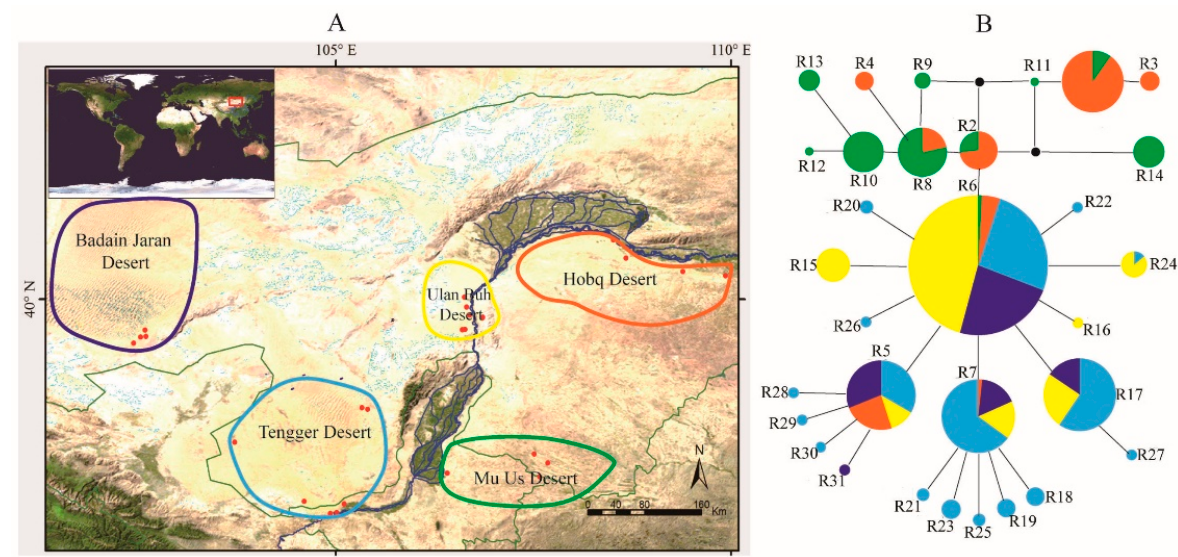
Figure 3. ( A ) The geographic distribution of the 28 Stilpnolepis centiflora populations in the deserts of northwestern China. Each desert is marked using different colors. ( B ) The networks of 31 ribo- types of S. centiflora . The size of circles corresponds to the frequency of each ribotype. Small black circles on the branches represent hypothetical missing ribotypes. Ribotypes are color-coded based on deserts: Purple: Badain Jaran; blue: Tengger; yellow: Ulan Buh; orange: Kubuqi; green: Mu Us.